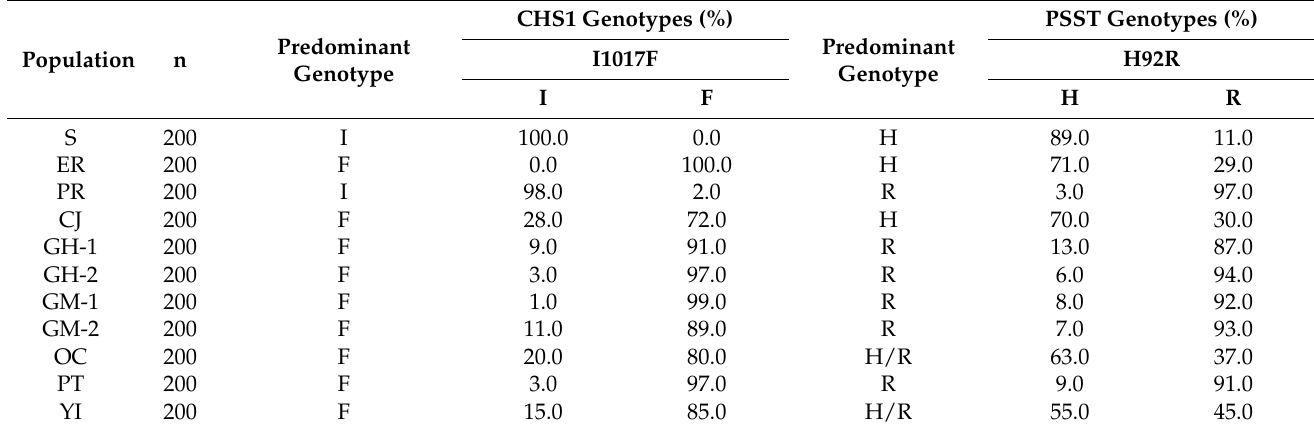
Table 10. Genotypes of point mutations in the CHS1 and PSST genes of T. urticae